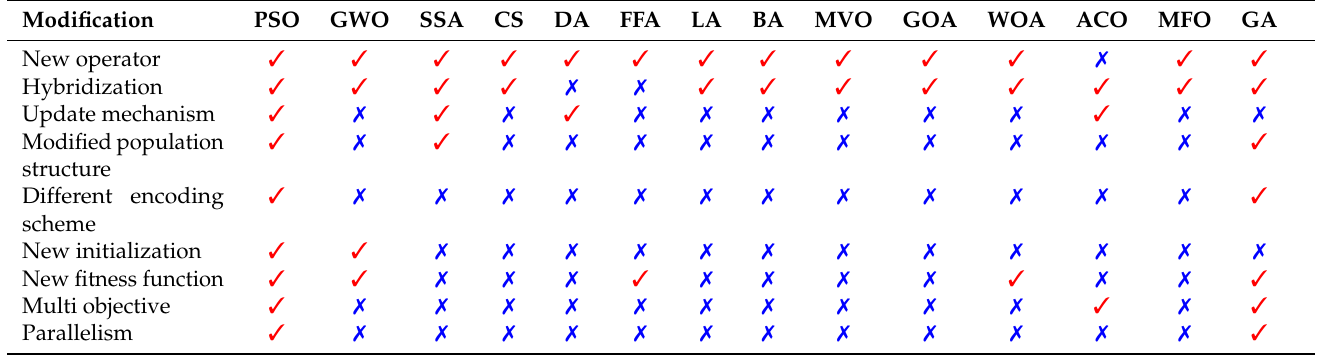
Table 4. Summary of main modifications applied in the literature on main NIAs-FS (applied/ not